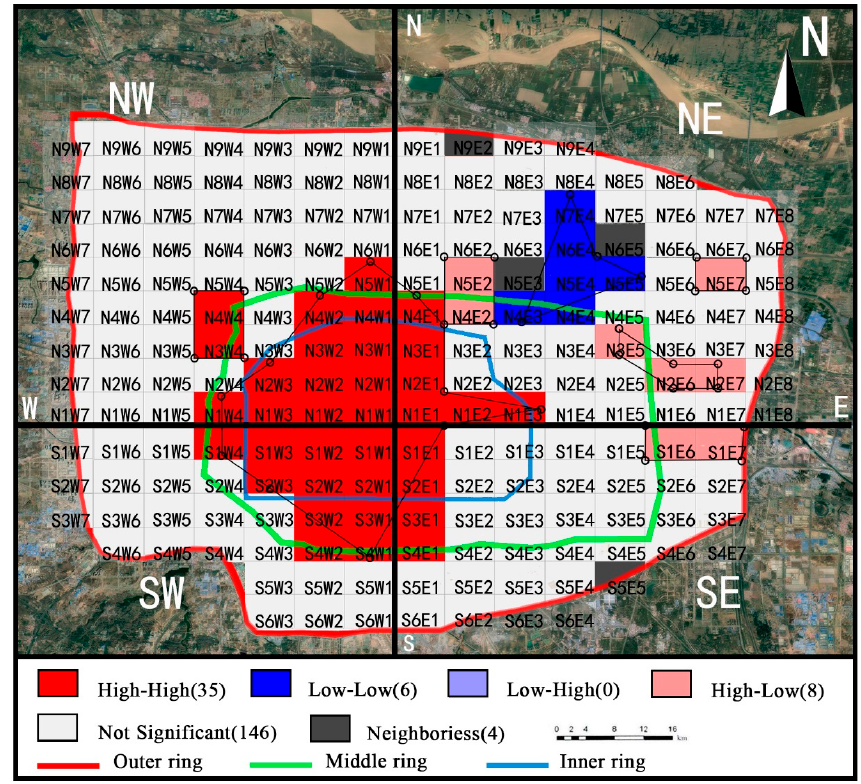
Figure 6. Local auto-correlation in 2D